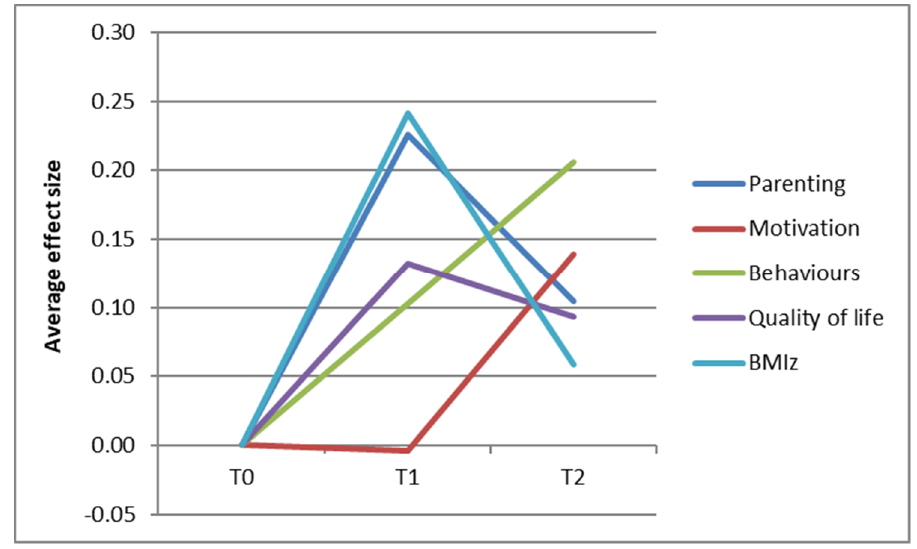
Figure 2. Overall changes among the parents and children regarding parenting, motivation, behaviours, quality of life and BMIz.